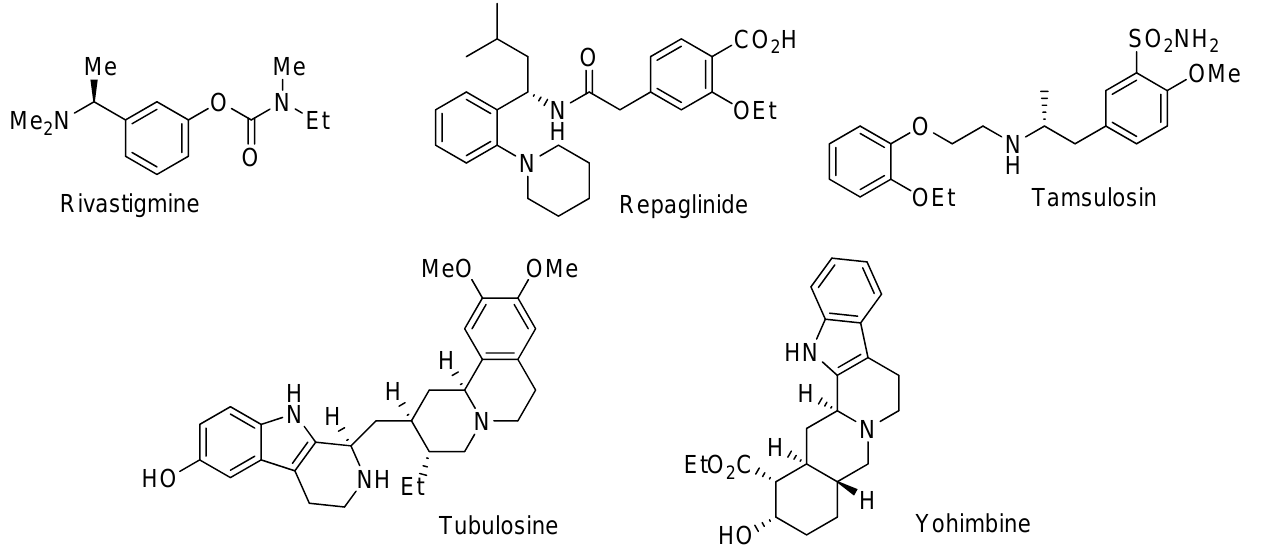
Figure 1. Examples of chiral amines in the pharmaceutical